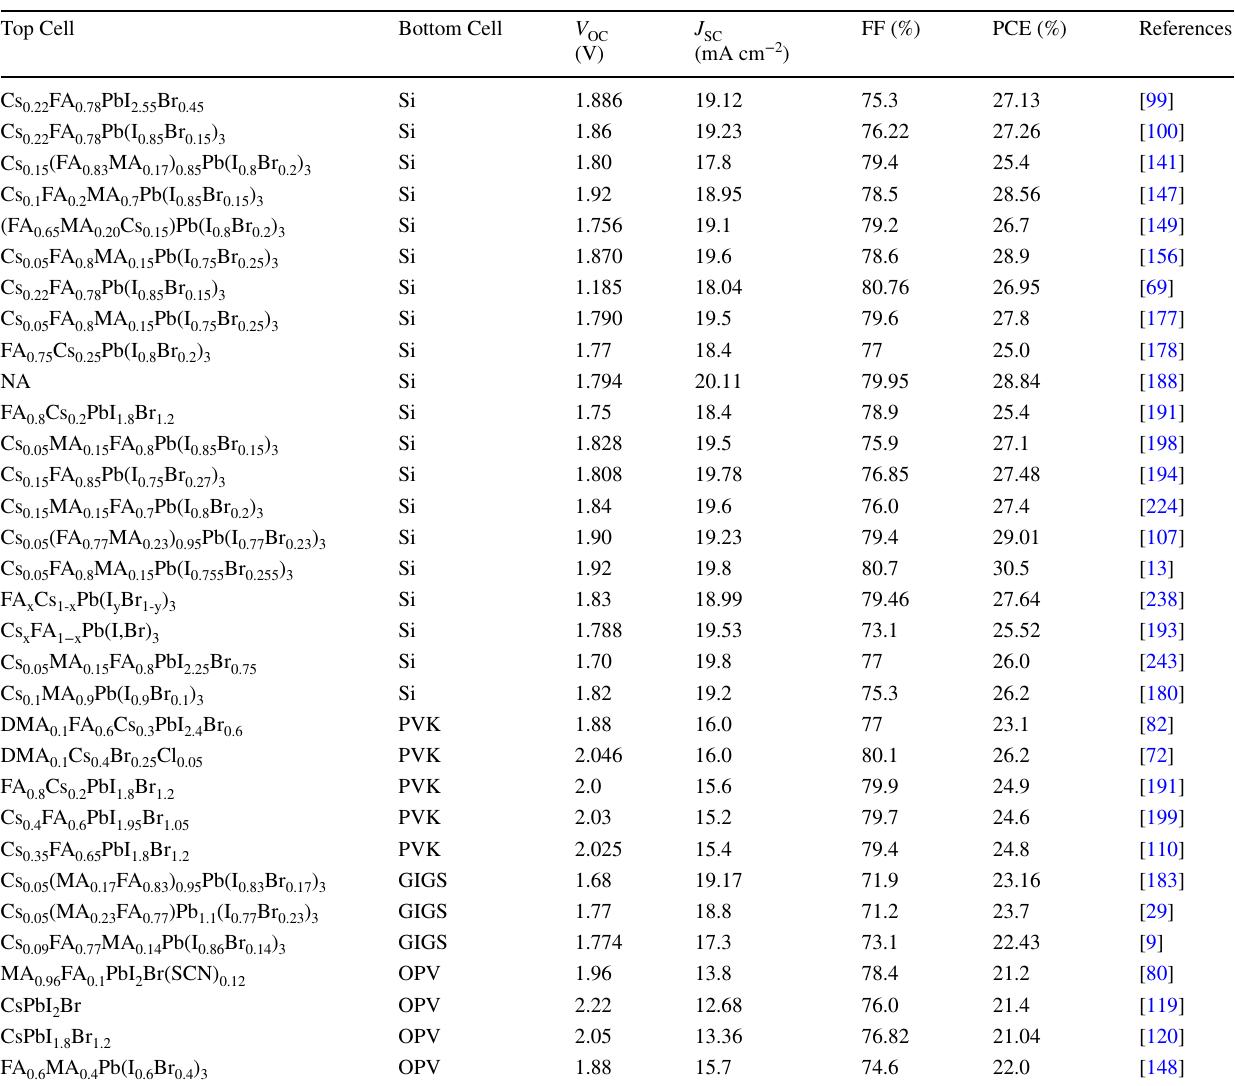
Nano-Micro Lett. Table 1 Summary of highly efficient perovskite-based TSCs Top Cell Bottom Cell V OC